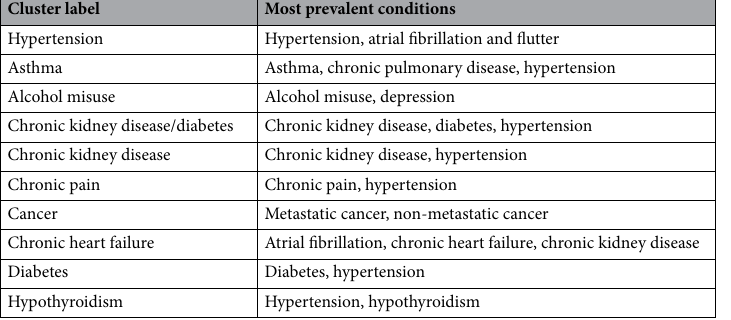
Table 4. Multimorbidity